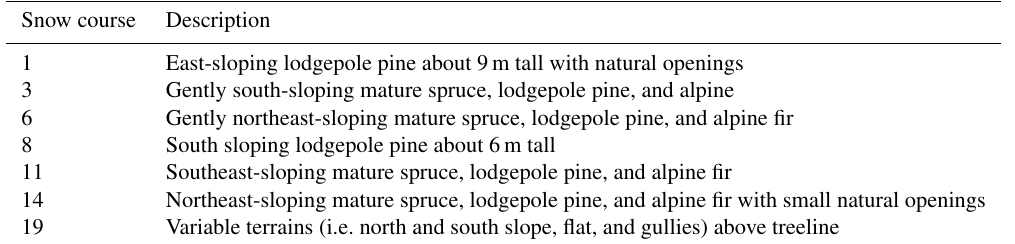
Table 5. Historical snow courses (SCs) at the Marmot Creek Research Basin from description by Fisera (1977). Snow course